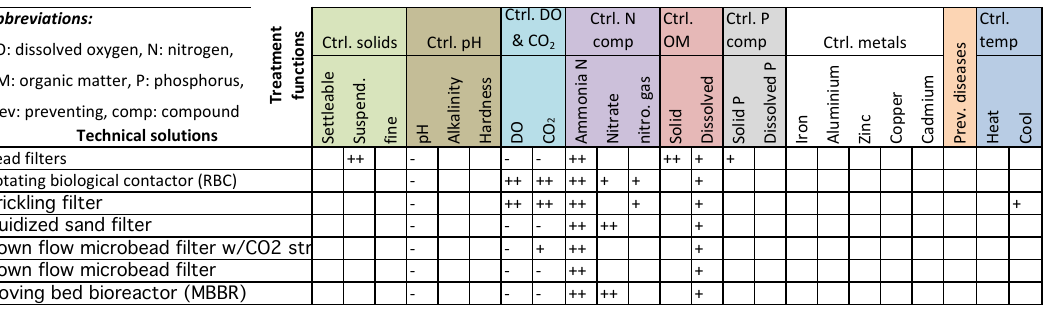
Table 6. QFD matrix presenting how biofilters influence different treatment